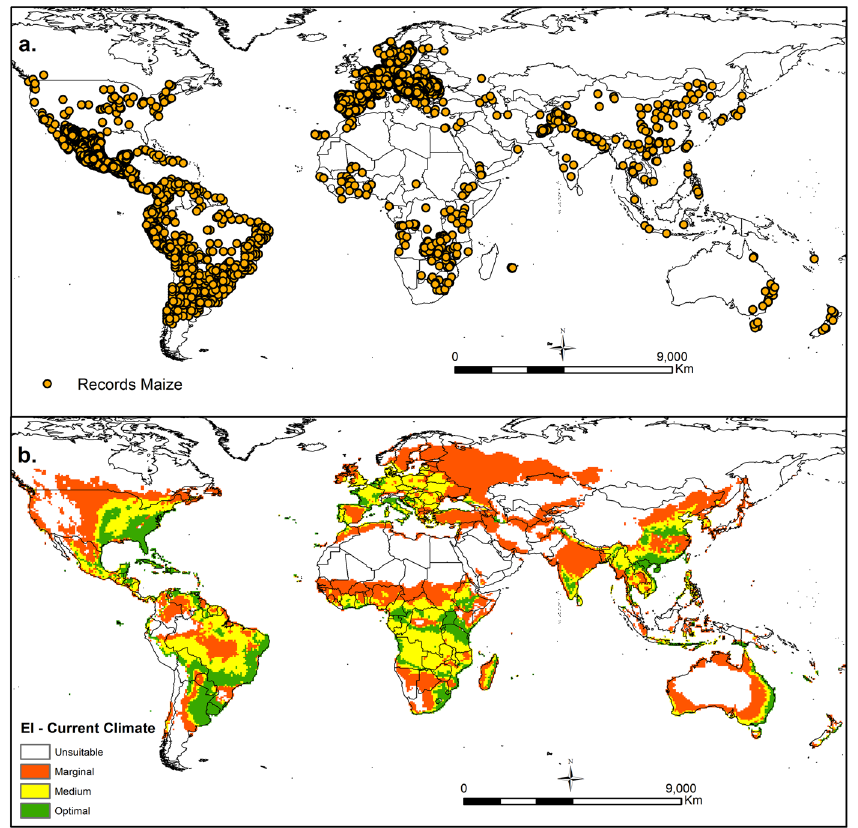
Figure 1. ( a) The current global distribution of maize ( Zea mays L.). ( b ) The ecoclimatic index (EI) for the current climate scenario of maize ( Zea mays L.). ArcMap 10.2